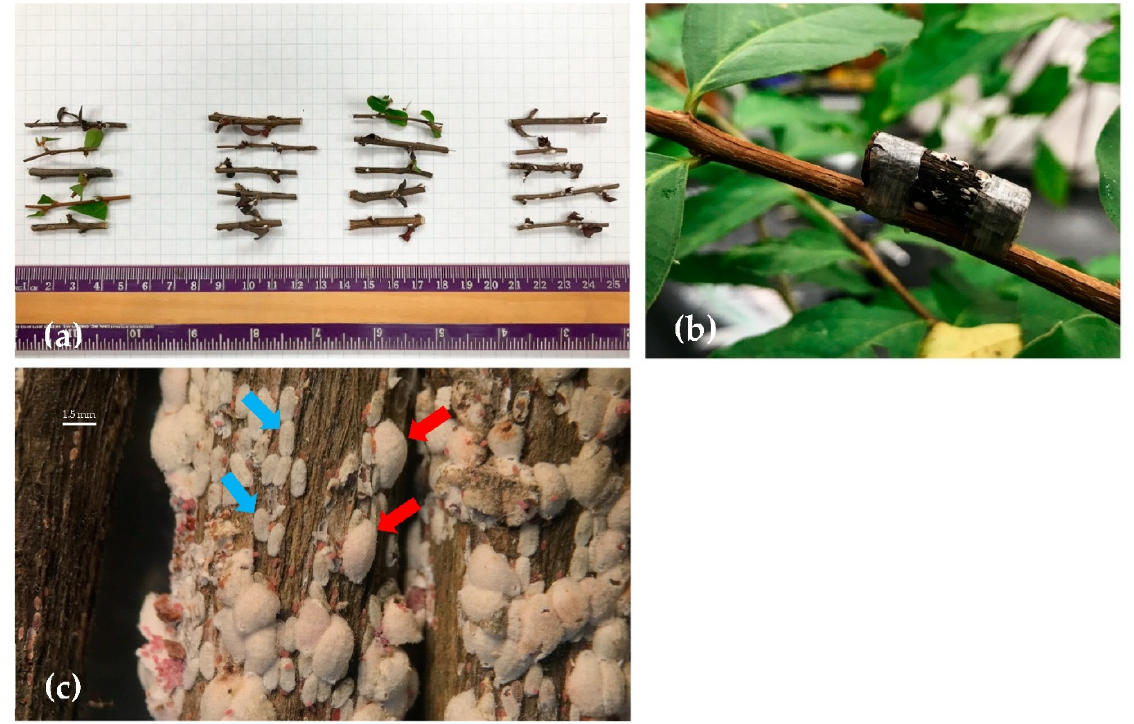
Figure 2. Crapemyrtle bark scale inoculation on six Lagerstroemia species and Lythrum californicum in one cage. ( a ) Three- centimeter-long CMBS-infected branches were collected from the nursery pad at the Department of Horticultural Sciences in Texas A&M University. ( b ) A CMBS-infected branch was tied on L. subcostata . ( c ) A closer look at the CMBS-infected branches; CMBS males (blue arrows) were recognized by white tubular sacs, and females (red arrows) were recognized by white round spindle-shaped ovisacs.